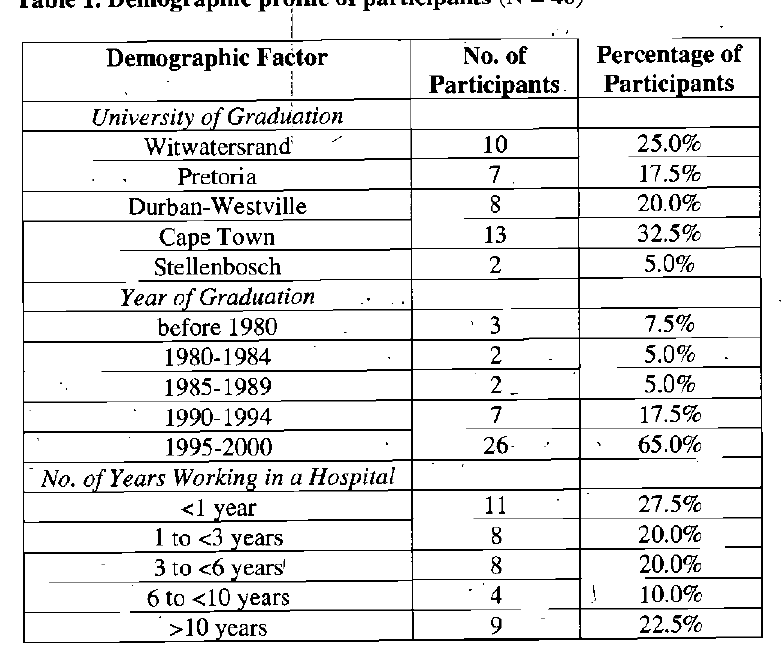
Table 1. Demographic profile of participants (N = 40) Demographic